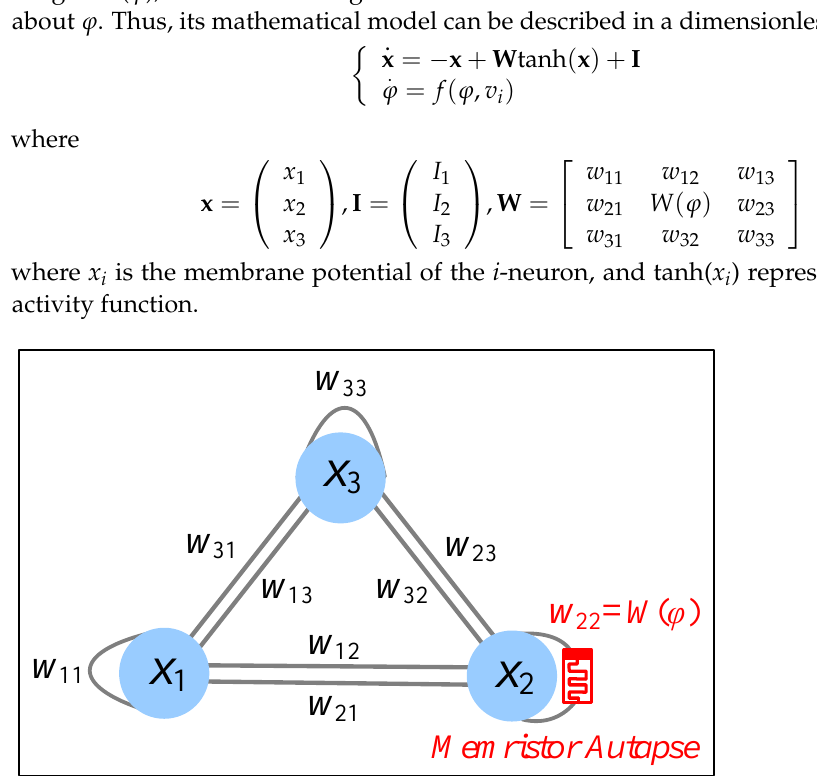
Figure 1. Connection topology of a memristor-autapse-based MHNN.